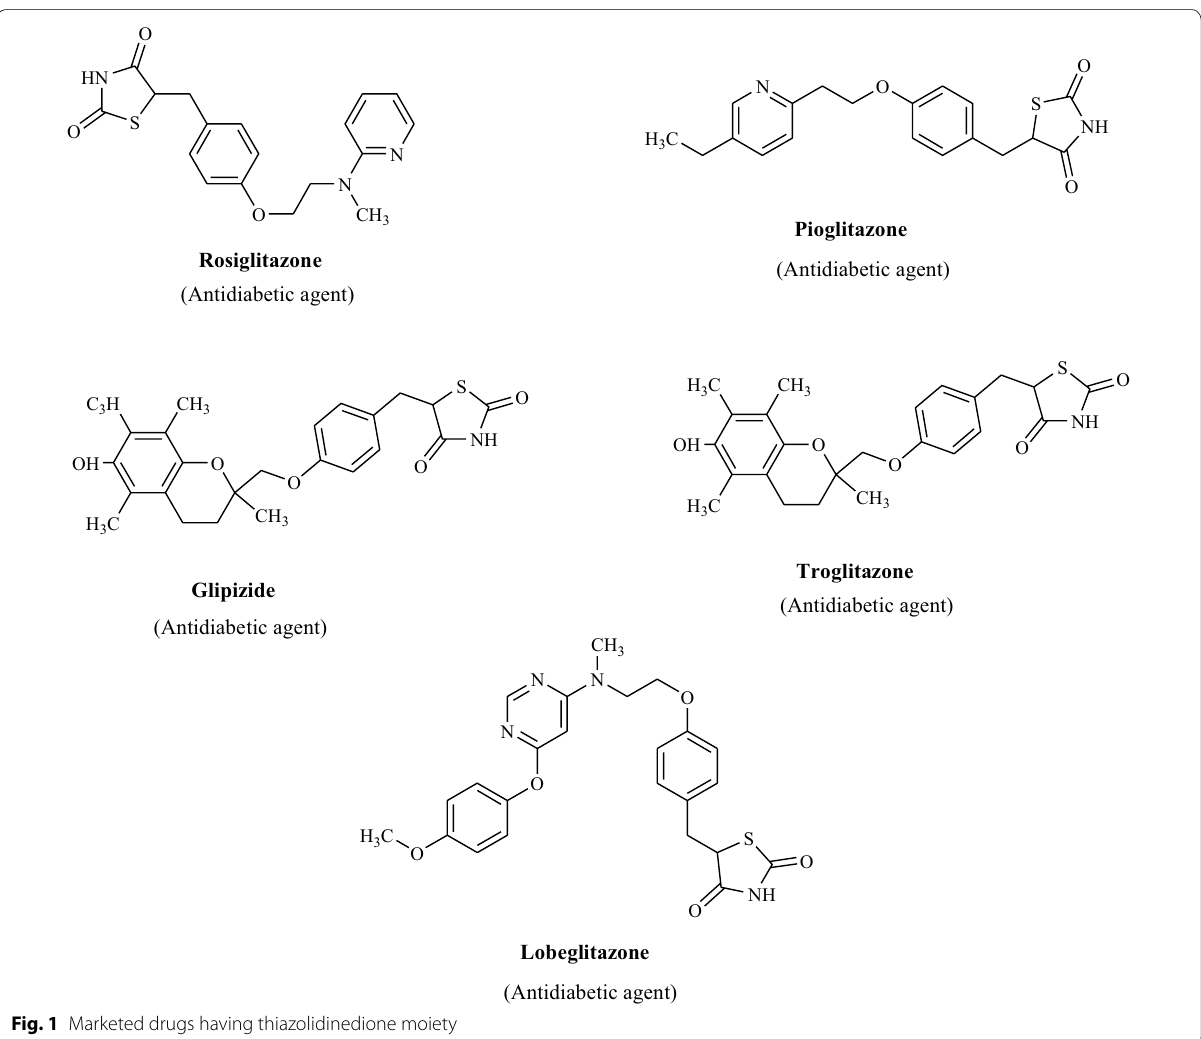
Fig. 1 Marketed drugs having thiazolidinedione